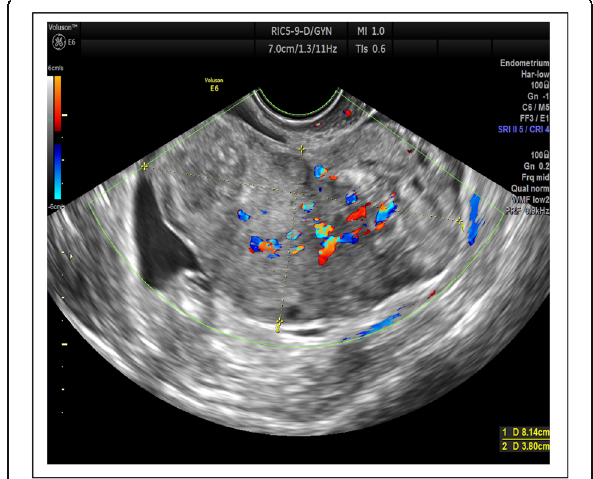
Fig. 10 GI-RADS 5. A 28-year-old female patient presented by vague abdominal pain and abdominal distention. On US and colour Doppler, an enlarged left ovary was seen with high central vascularity, lack of arborization mimicking malignant circulation. CA 125 was normal. On follow-up US, regression of the mass took place. Final diagnosis of ovarian torsion-detorsion was